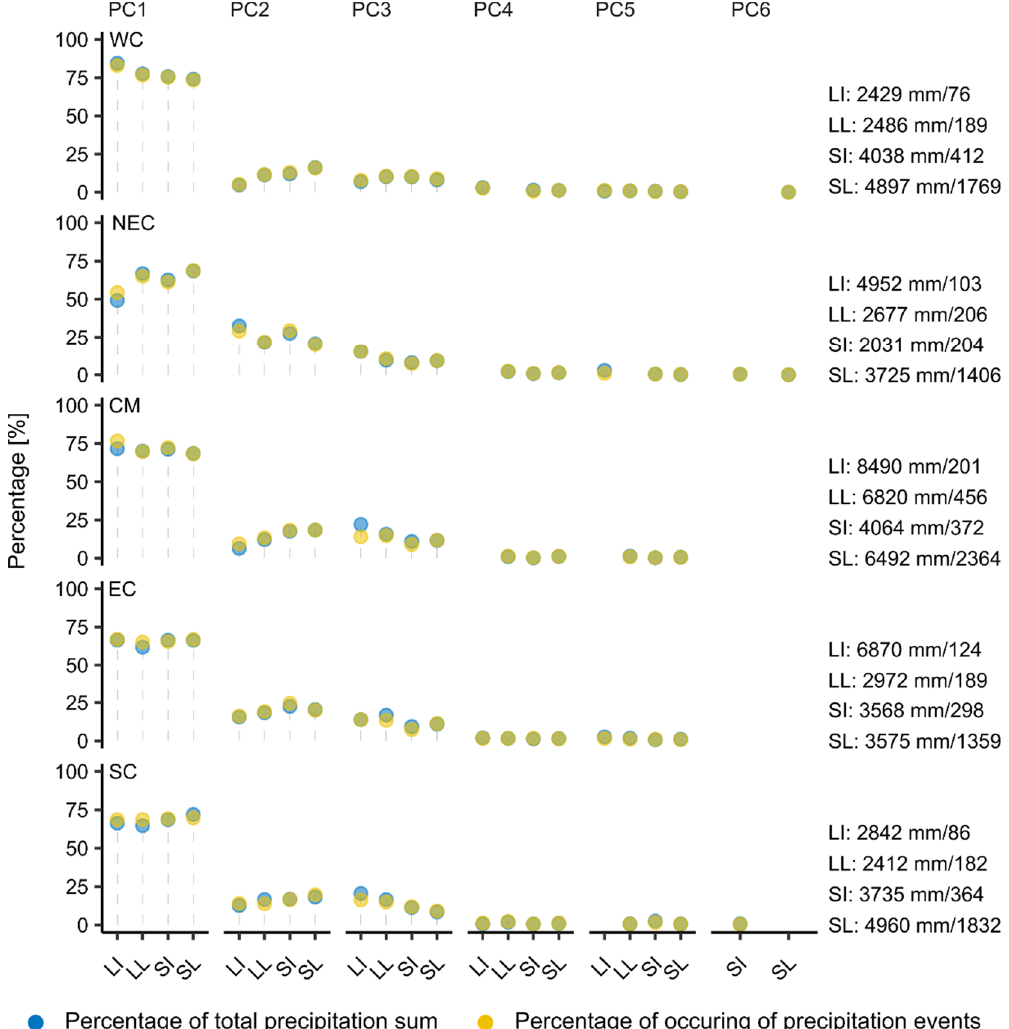
Figure 5. Percentage of occurrence of rain class per region and PC, the related percentage of precipitation sum within these precipitation events as well as total amount of precipitation sum and precipitation events within individual precipitation regime and precipitation class.